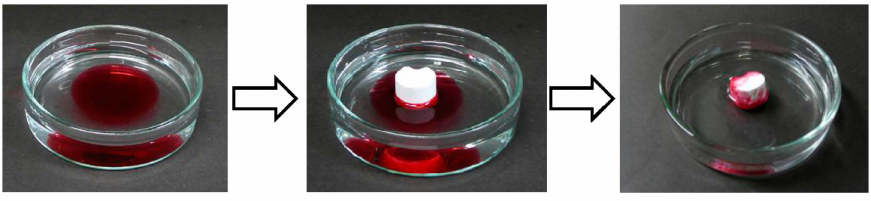
Figure 8. Separation of linseed oil layer on water surface using P3HB3HH 6